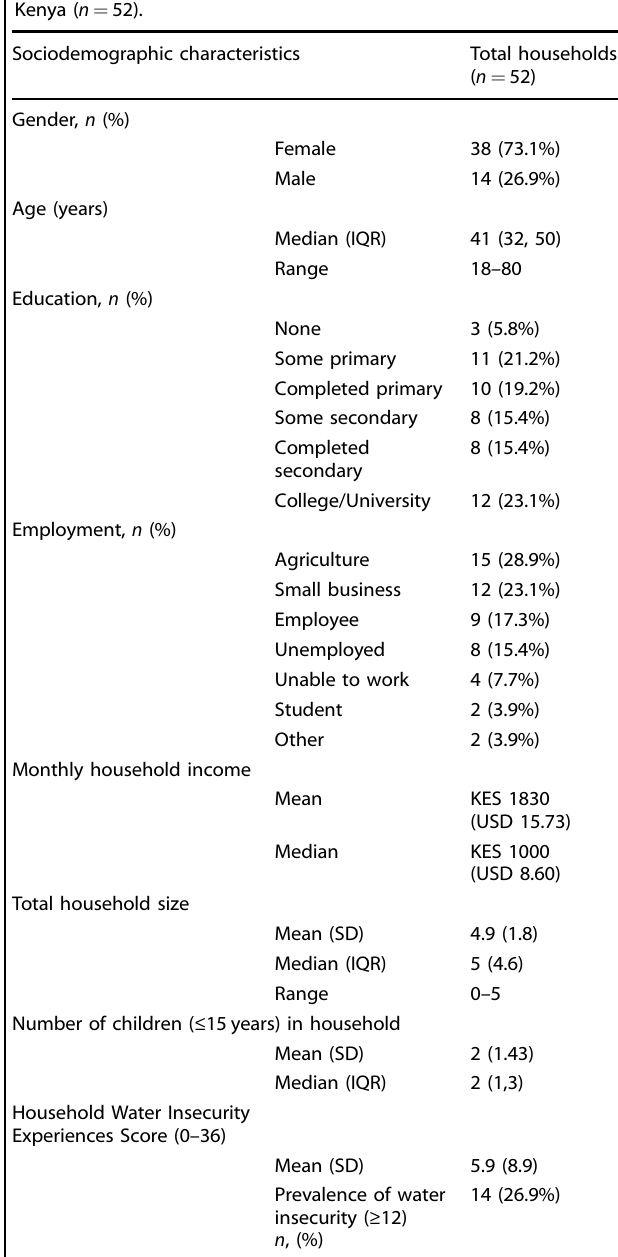
Table 2. Characteristics of water samples available for assessment of accuracy of at-home biosensor fl uoride tests ( n = 57) a